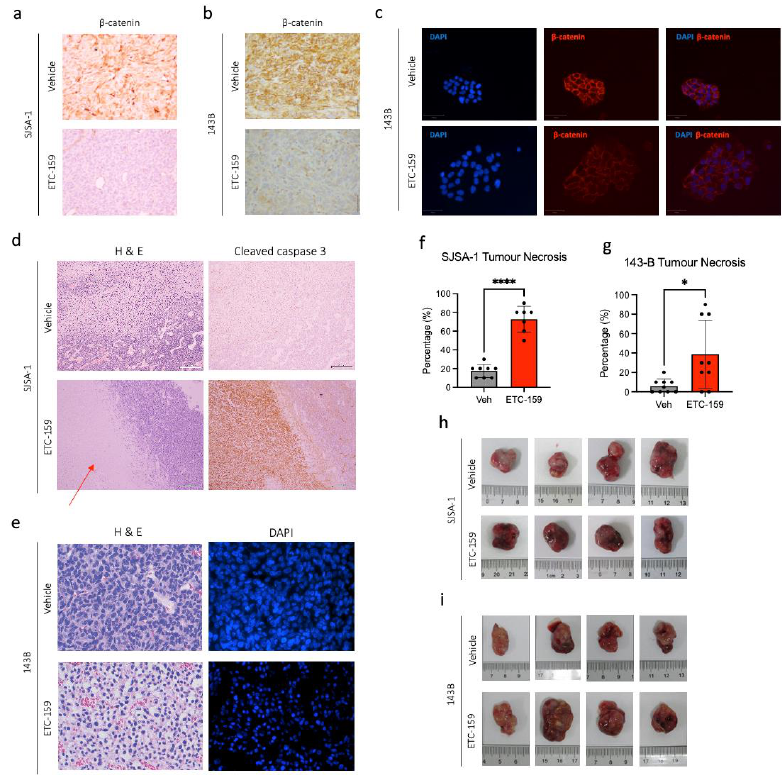
Figure 2. Effect of ETC-159 on osteosarcoma xenografts. Mice bearing OS xenografts were gavaged with 30 mg/kg ETC-159 daily. IHC staining in ( a ) SJSA-1 and ( b ) 143B xenograft sections show marked reduction in β -catenin following ETC-159 treatment. Images were captured at 200 × magnification. ( c ) Immunofluorescence staining for β -catenin following treatment with ETC-159 shows a similar reduction. Images were captured at 100 × magnification. ( d ) Decreased eosin staining in SJSA-1 xenograft sections after ETC-159 treatment. Red arrow indicates necrotic region of tumour. IHC shows increased cleaved caspase 3 (indicating apoptosis) following ETC-159 treatment. This region also overlaps with necrotic region of tumour identified by H&E staining. Images captured at 100 × magnification. ( e ) H&E staining of 143B xenograft shows increased pyknotic nuclei following ETC-159 treatment and decreased eosin stain uptake due to tumour necrosis within xenograft. This is also clearly seen when nuclei are stained for DAPI. Images captured at 400 × magnification. Scatter plots showing percentage tumour necrosis of tumour in ( f ) SJSA-1 or ( g ) 143B xenografts. Each point represents an individual tumour. Percentage of tumour necrosis was derived by quantifying the number of pyknotic nuclei in H&E-stained sections. * indicates p < 0.05, **** indicates p < 0.0001. Significance was calculated with unpaired two-tailed Student’s t -test. Increased tumour haemorrhage seen in ( h ) SJSA-1 and ( i ) 143B tumours following ETC-159